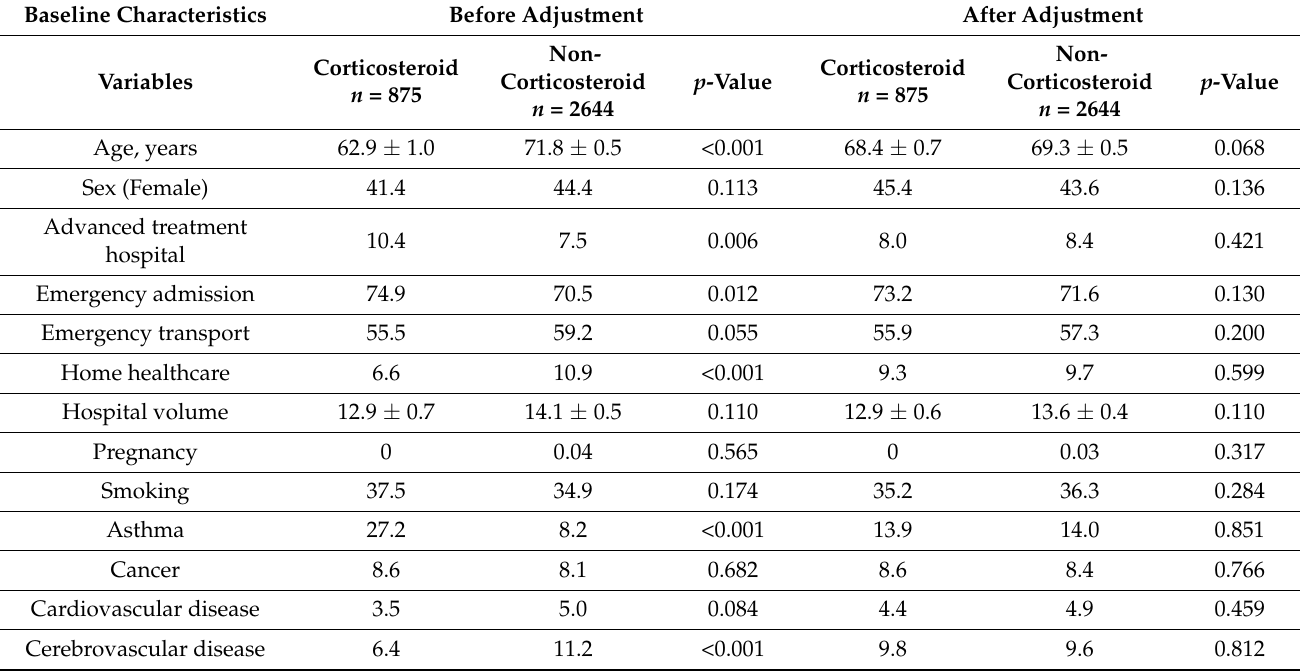
Table 1. Baseline characteristics of patients treated with or without corticosteroids before and after adjusting for confounders using the propensity score weighting method. Baseline Characteristics Before Adjustment After